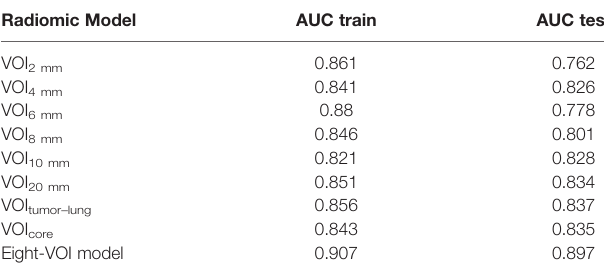
TABLE 3 | Diagnostic performances of the eight separate models and the 8-VOI model. Radiomic